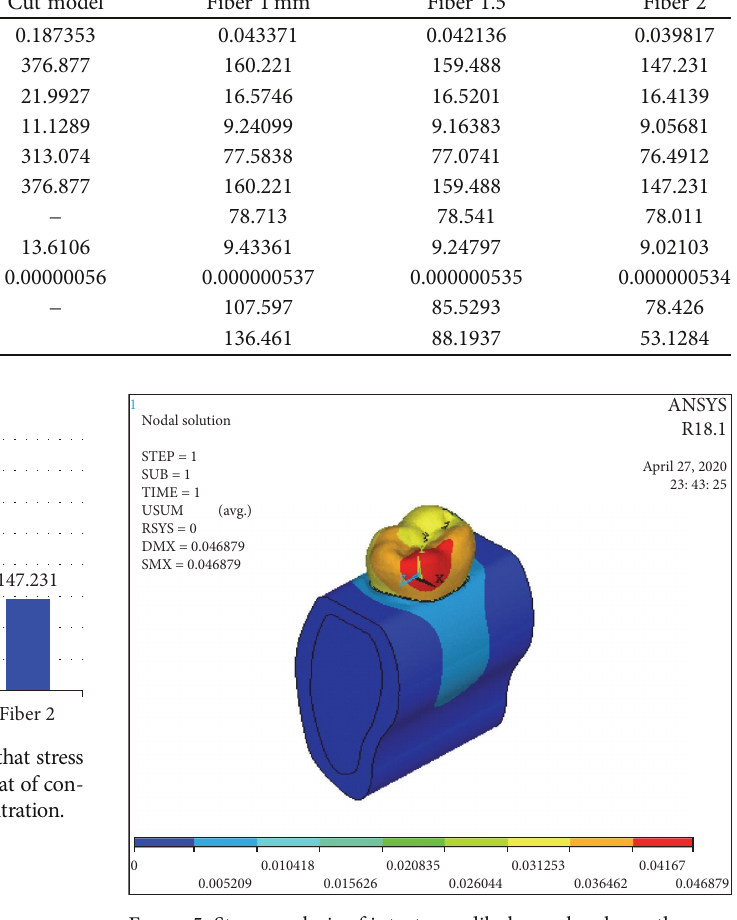
F IGURE 5: Stress analysis of intact mandibular molar shows the con- centration of stress on the functional cusp.